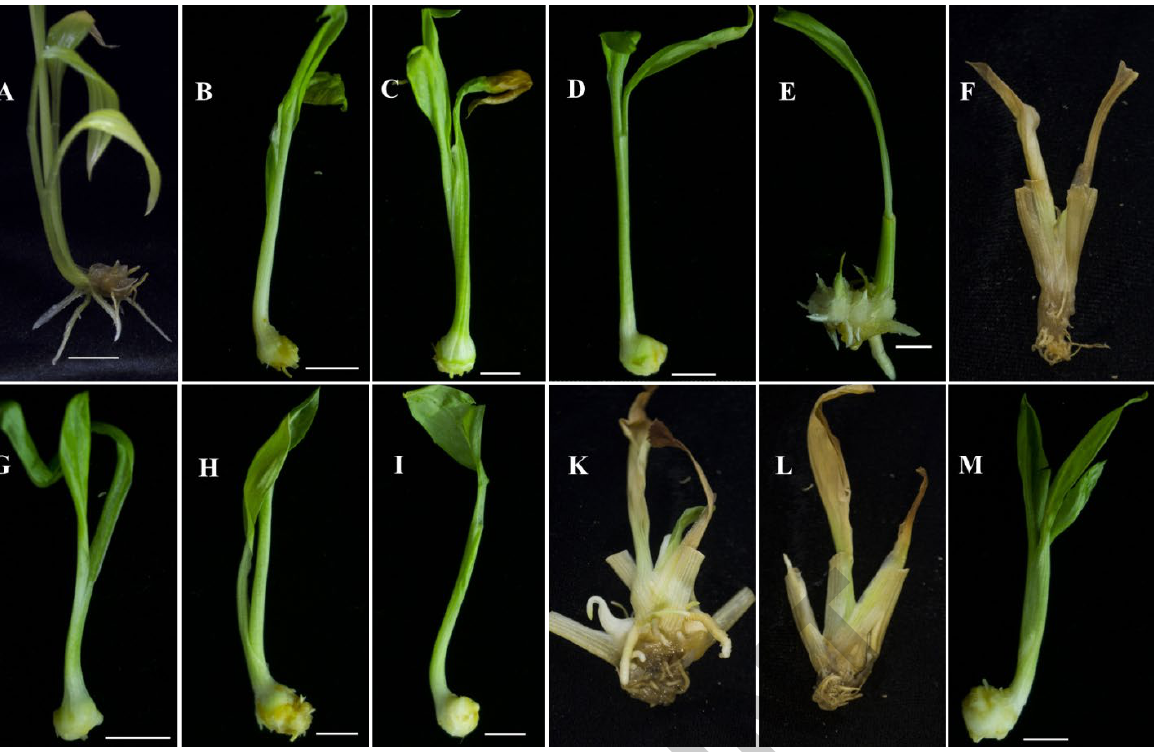
Figure 1. Typical microrhizomes grown on media with different supplements: MS + 30 g/L sucrose (A); MS + 80 g/L sucrose (B); MS + 80 g/L sucrose + 11 μM AgNO 3 + 1 mg/L BAP (C); MS + 80 g/L sucrose + 11 μM AgNO 3 + 1 mg/L KIN (D); MS + 80 g/L sucrose + 11 μM AgNO 3 + 2–6 mg/L NAA (E); MS + 80 g/L sucrose + 11 μM AgNO 3 + 8 mg/L NAA (F); MS + 80 g/L sucrose +